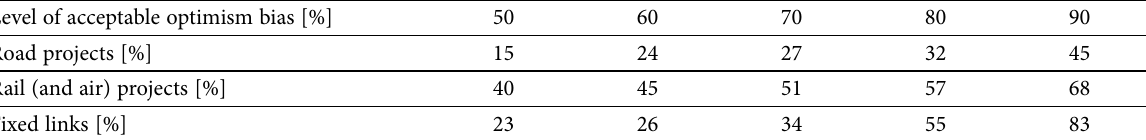
Table 4. Optimism Bias uplifts (adapted from Flyvbjerg 2004) Level of acceptable optimism bias [%]